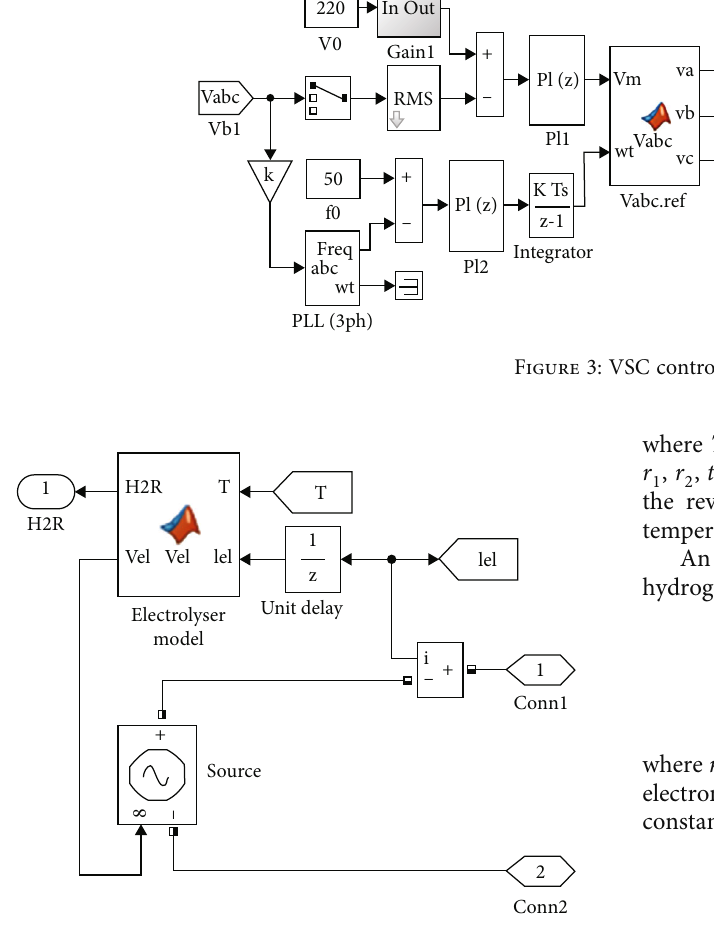
Figure 4: Electrolyzer model in